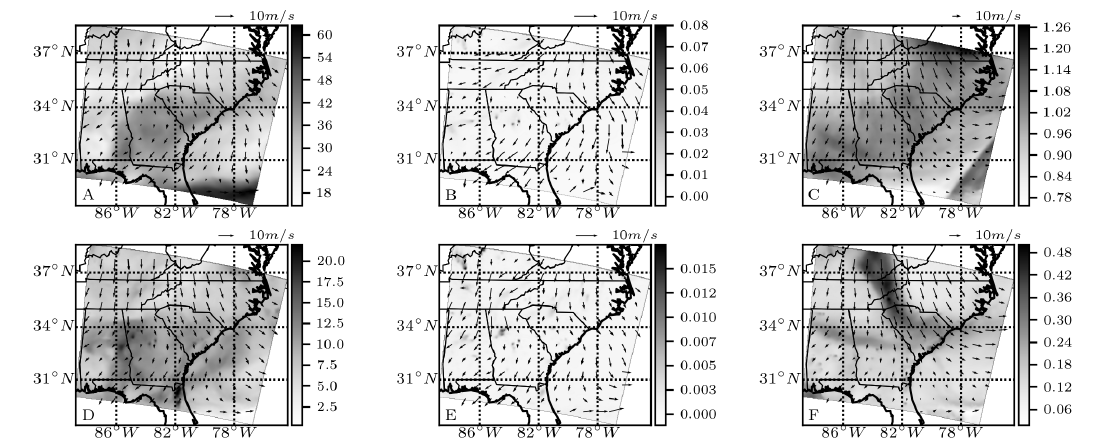
Figure 3. Vertically-integrated species amounts Q s (in kg/m 2 for H 2 O and in mg/m 2 for other species, as shown in the color bar) superimposed with the species effective flux-based velocity field Φ s ; the effective velocity vector arrow scale, 10 m/s, is given. The species for each plot are: ( A ) H 2 O, ( B ) SO 2 , ( C ) O 3 , ( D ) SO 2 − , ( E ) NO 2 , and ( F ) Na + 4